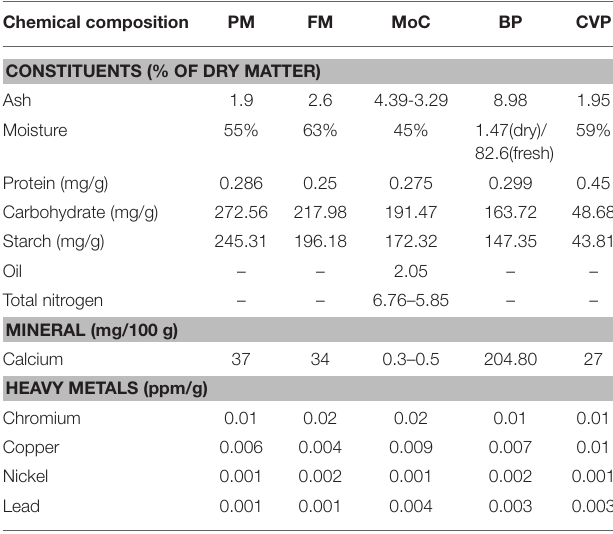
TABLE 1 | Chemical composition of various agro-wastes selected for amylase production using fermentation. Chemical